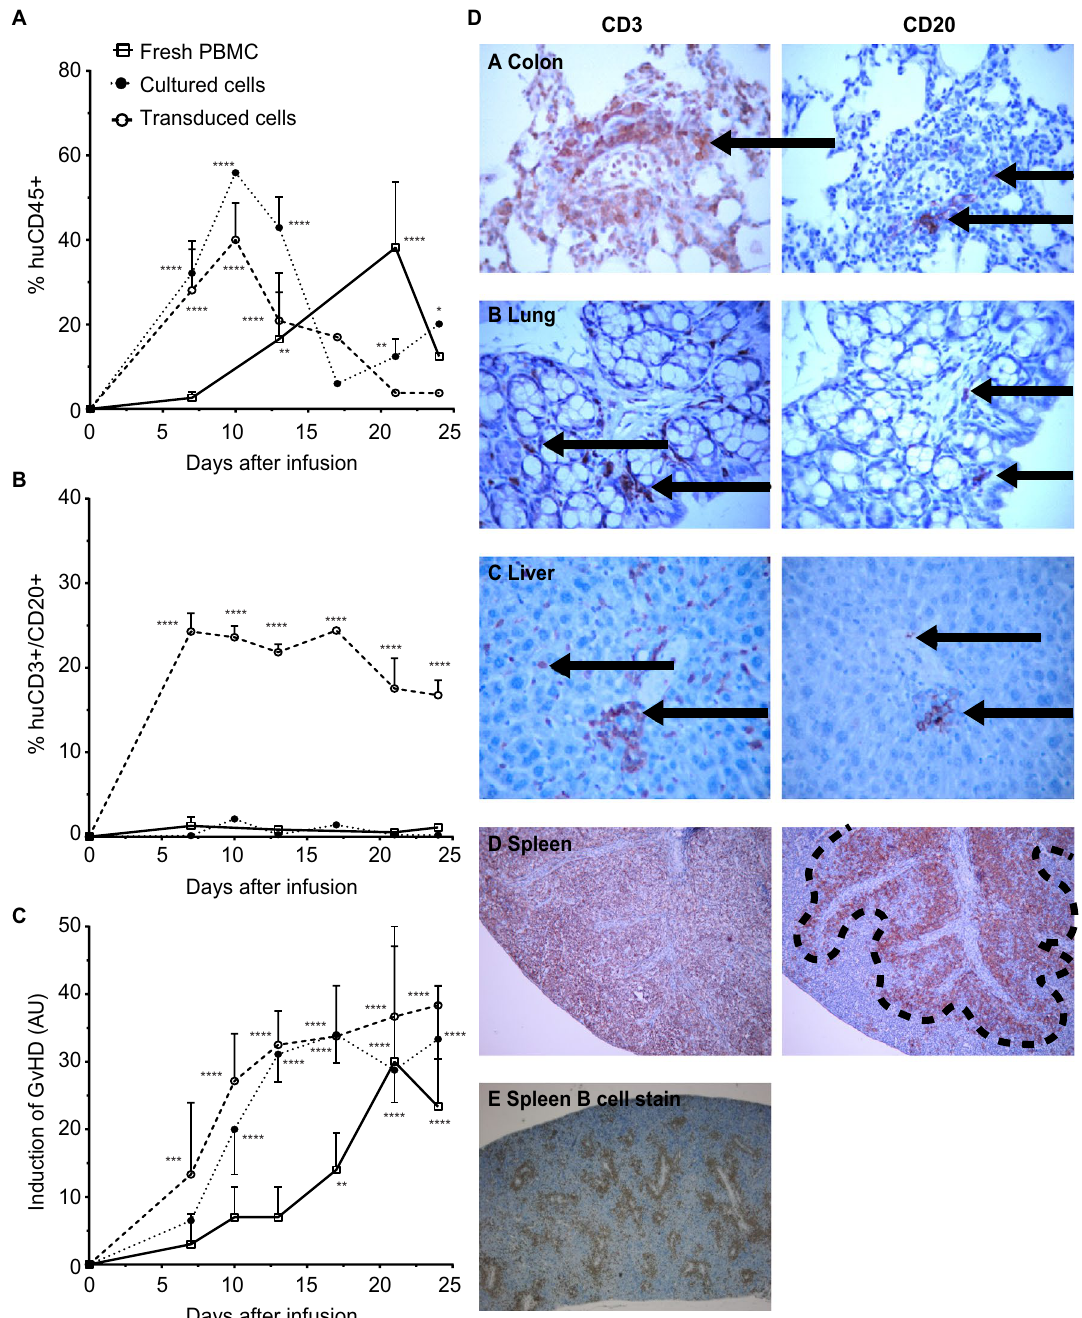
Figure 5. CD20 + T lymphocytes engraft, cause X-GvHD in RAG2-/-γc-/- mice and display altered adhesive pattern in mouse spleens. ( A ) 15 × 10^6 fresh huPBMCs (n = 5), 40 × 10^6 CD3/CD28 stimulated cultured primary T cells (n = 10) and 40 × 10^6 CD3/CD28 stimulated CD20-transduced primary T cells (n = 10) from the same donor were injected into irradiated and macrophage-depleted mice. The non-transduced and transduced cells were cultured for 6 days. Peripheral blood was collected once a week and the percentage of human CD45 and ( B ) CD3/CD20 + cells was determined. ( C ) The capability of the T cells to induce GvHD was determined by weight loss, reduced mobility of the mice and development of ruffled fur. These criteria were scored as arbitrary units (AU) and set against time. The mean ± SD are shown. 2way ANOVA’s were performed to deterime significance. ( D ) Immunohistochemical evaluation was performed in mice injected with T cells ectopically expressing CD20. Infiltration of human CD3 + cells is shown in the left columns and the infiltration of CD20 + cells into the organs is shown in the right columns. These figures show the colon A, the lung B, the liver C, the spleen D and spleen E (injection of non-transduced human PBMCs, anti-CD20 B cell